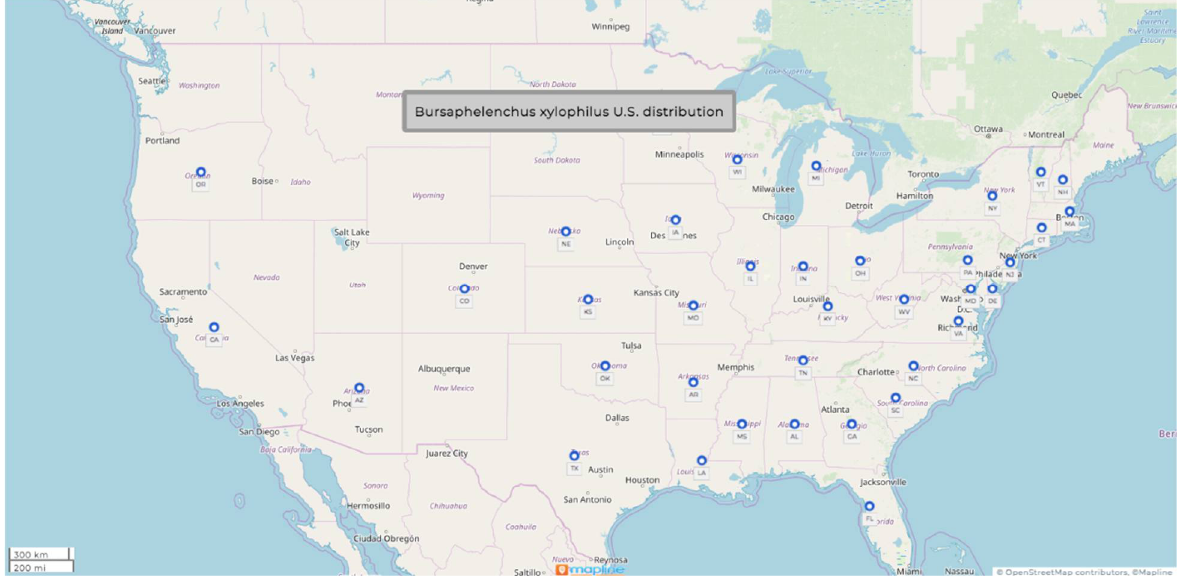
Figure 1. Distribution map of Bursaphelenchus xylophilus (adapted from CABI-ISC [26]). Symptoms : Destruction of cortical and cambial tissues are the most common symptoms associated with this nematode. It is followed by cavitation-induced embolism of xylem tracheids. According to Donald et al. [28], the nematode induces a cascading series of hypersensitive reactions in xylem parenchyma cells as it spreads throughout a